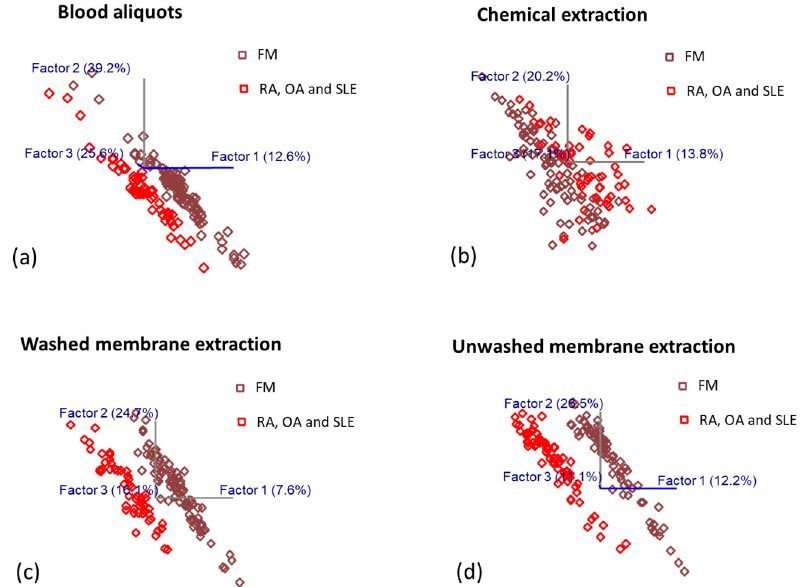
Figure 4. The score plots with the first three latent variables (LVs) of OPLS-DA regression models obtained from the spectral data of samples prepared by ( a ) redissolving blood aliquots, ( b ) chemical extraction, ( c ) washed membrane extraction (LMF), and ( d ) unwashed membrane extraction (LMF with glycerol).